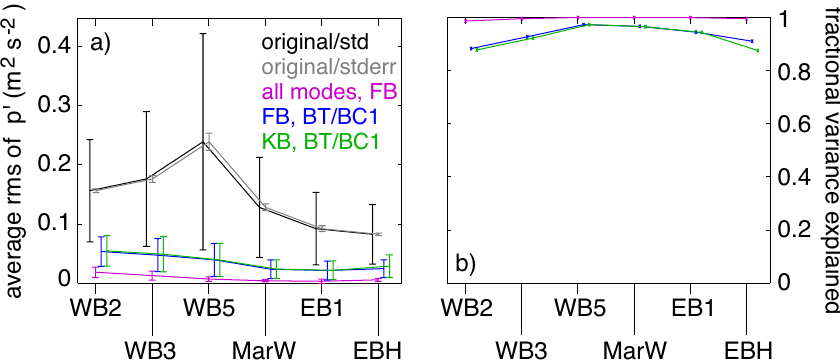
Fig. 5. (a) Time averages of vertical rms for the original signal (black with error bars), the residual from the complete flat-bottomed recon- struction (pink with error bars), the M = 2 flat-bottomed reconstruction residual (blue with error bars), and the M = 2 KB reconstruction residual (green with error bars). Standard deviations are shown over the entire record length with the error bars. In addition, the standard error of the mean for the original signal is also indicated (gray error bars). (b) Fractional variance (see text) explained by the full flat-bottomed reconstruction (purple), the M = 2 flat-bottomed reconstruction (blue), and the M = 2 KB reconstruction